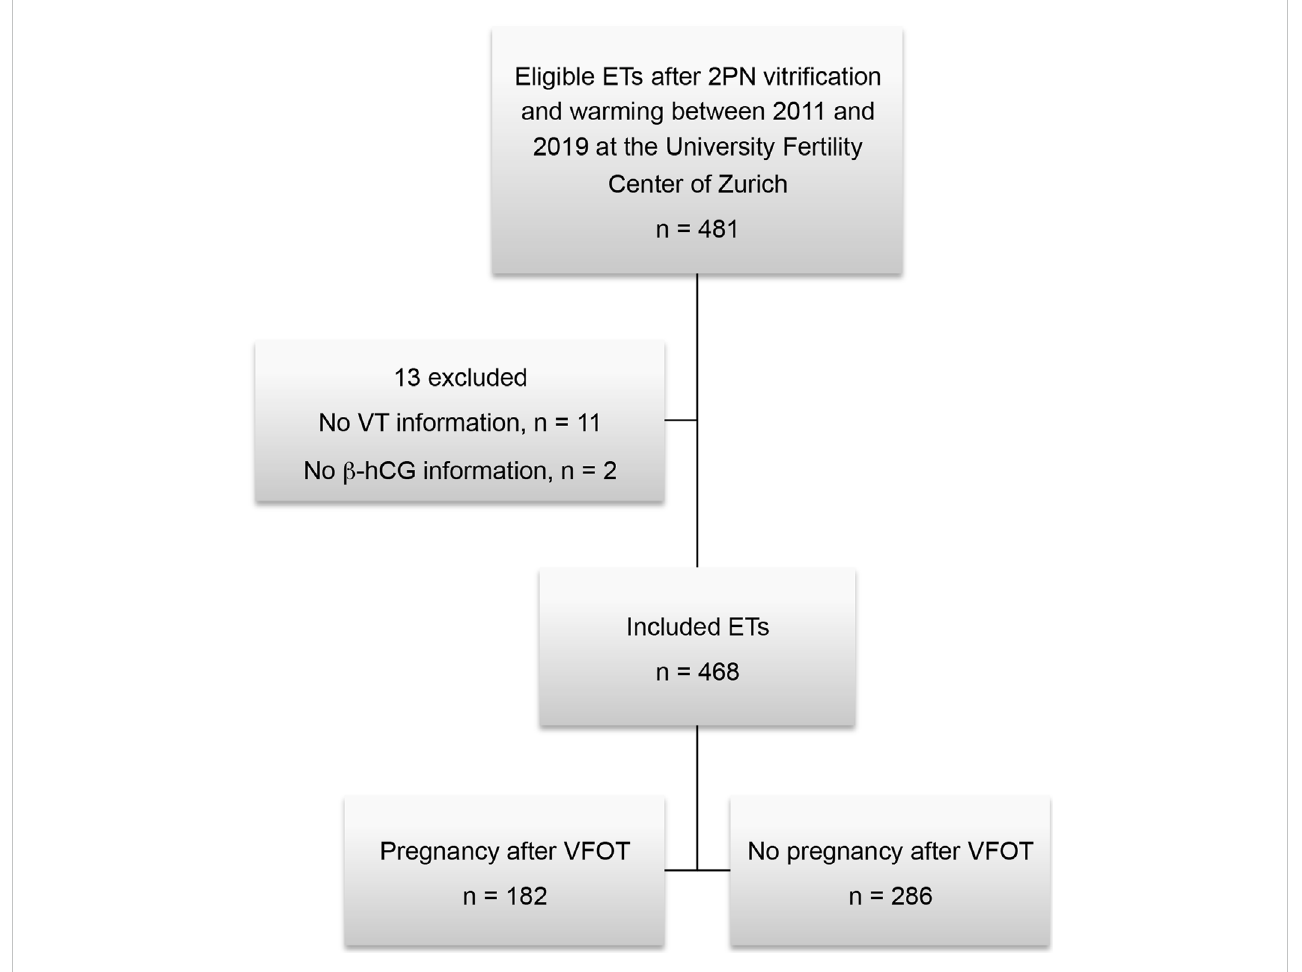
FIGURE 1 Overview of the study cohort. ET, embryo transfer; VT, vitri fi cation time; VFOT, transfer after vitri fi ed 2PNs.